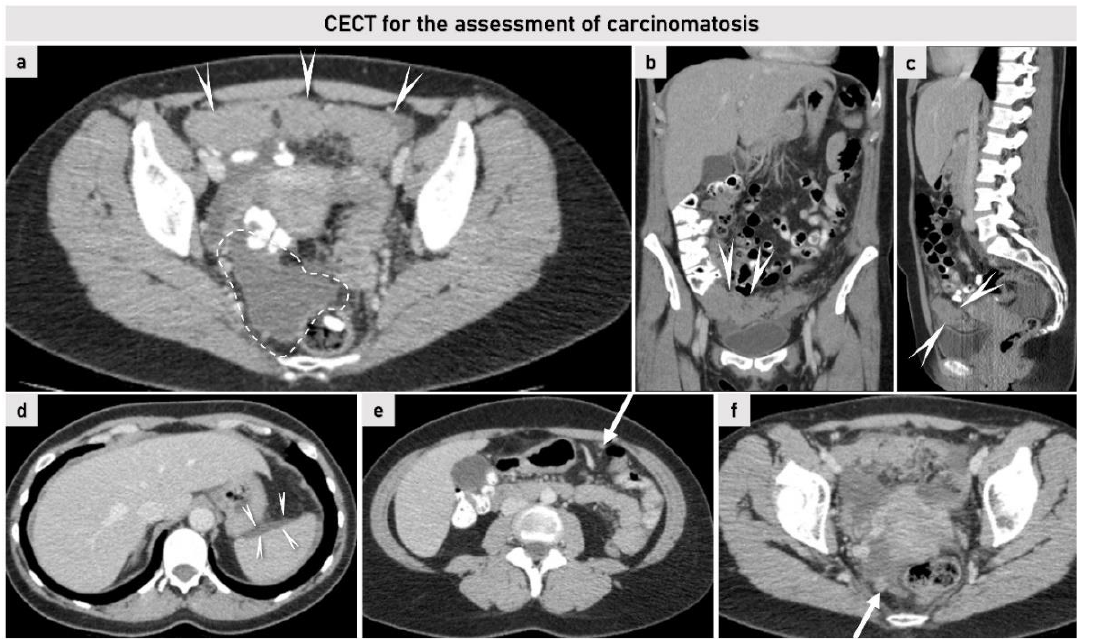
Figure 8. CT at primary diagnostic work-up in a patient aged 45 years presenting with symptoms of bloating and obstipation. Contrast-enhanced CT shows large omental mass ventral to the uterus and cranial to the bladder ( a – c ; marked with arrow outlines). Pelvic peritoneal carcinomatosis is indicated by a dotted line ( a ) and arrow ( f ). Peritoneal lesions in the upper abdomen can be seen on the surface of the spleen marked with an arrow outlines ( d ), as well as nodular infiltration of infracolic omentum marked with an arrow ( e ). The patient was diagnosed with ovarian cancer (adenocarcinoma) FIGO stage IIIC. Figures ( a , d , e , f ), axial (transverse) plane; figure ( b ), coronal plane; figure ( c ), sagittal plane. CECT, contrast-enhanced computed tomography; FIGO, International Federation of Gynecology and Obstetrics.